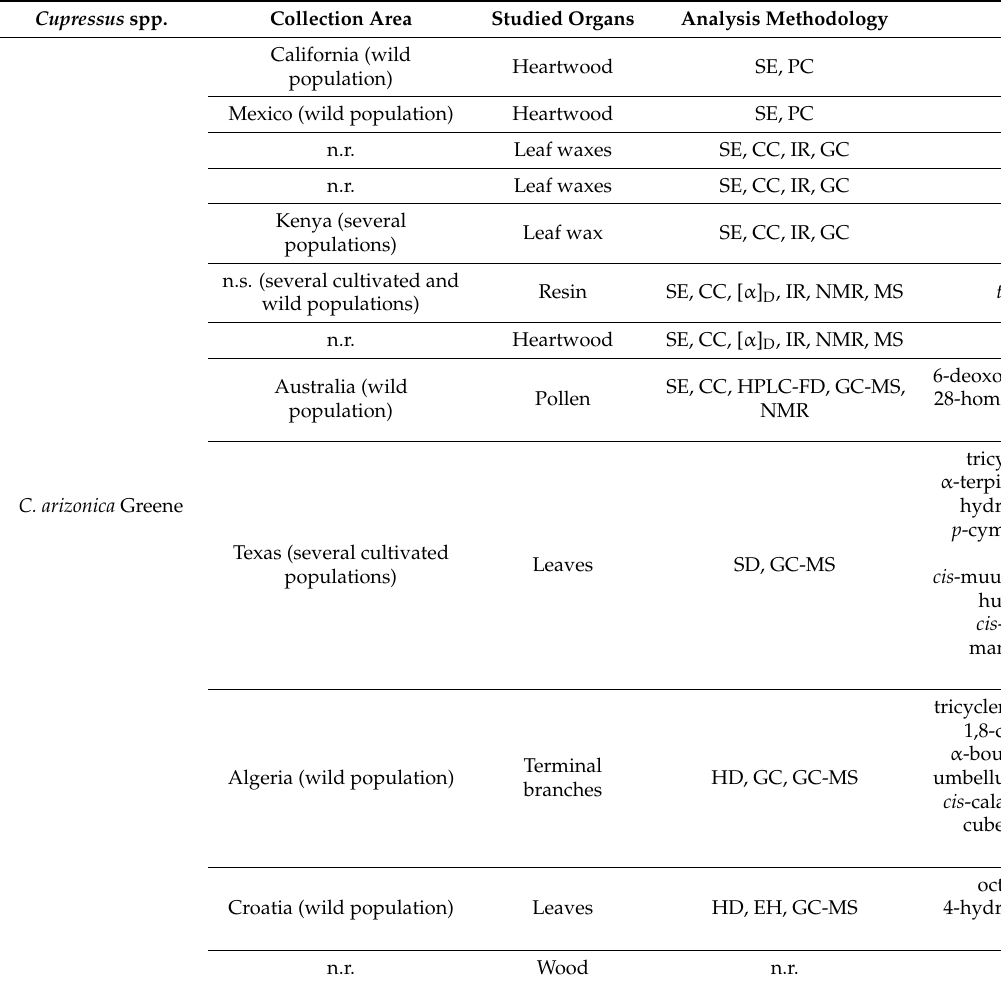
Table 1. Phytochemical compounds reported in Cupressus